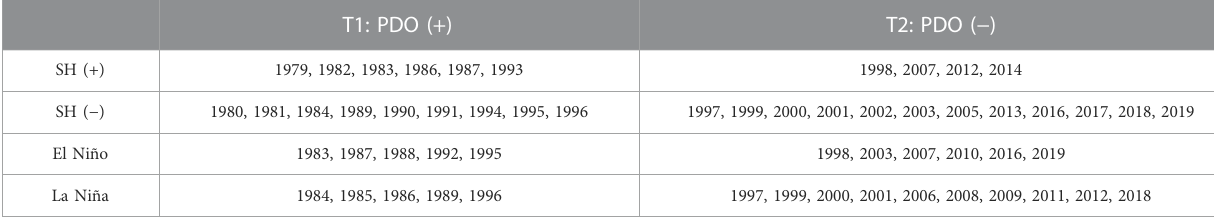
indicates that the PDO may play a moderating role on the ENSO and its relationship with midsummer precipitation in South China.